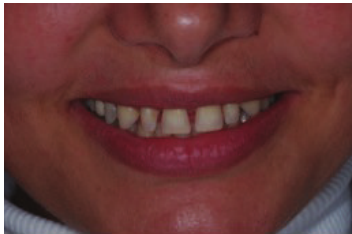
Figure 3: Diagnostic wax-up.